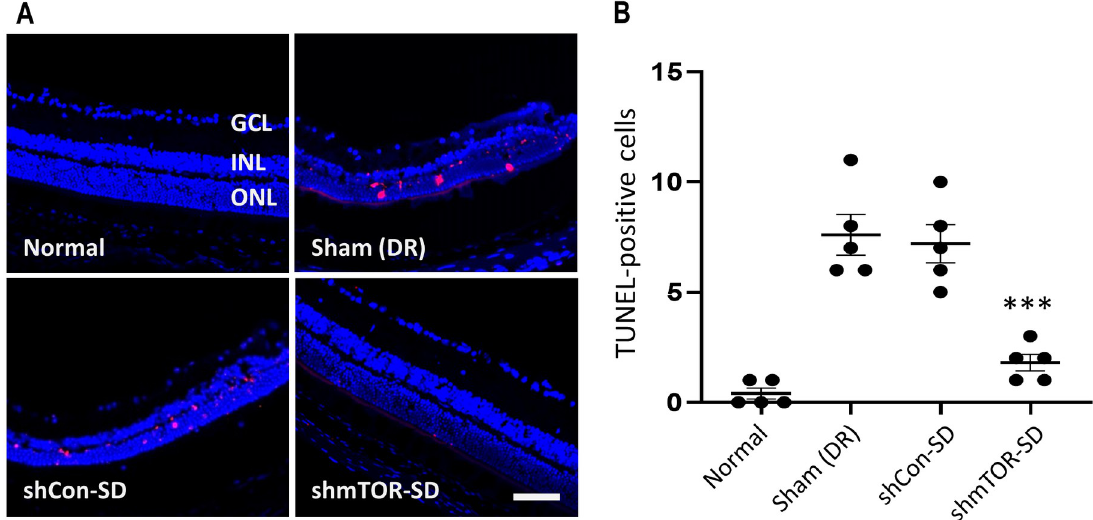
Fig 5. Anti-apoptotic effect of rAAV2-shmTOR-SD, as determined via TUNEL assay. (a) TUNEL-positive cells could not be found in transverse retinal sections of the normal control group, which were not treated with STZ, but were detected in sham-treated control mice and those injected with rAAV2-shCon-SD. Significantly fewer apoptotic cells were observed in mice treated with the therapeutic virus vector. Scale bar = 50 μ m. (b) Number of TUNEL-positive cells. Data represented as mean ± SEM (n =